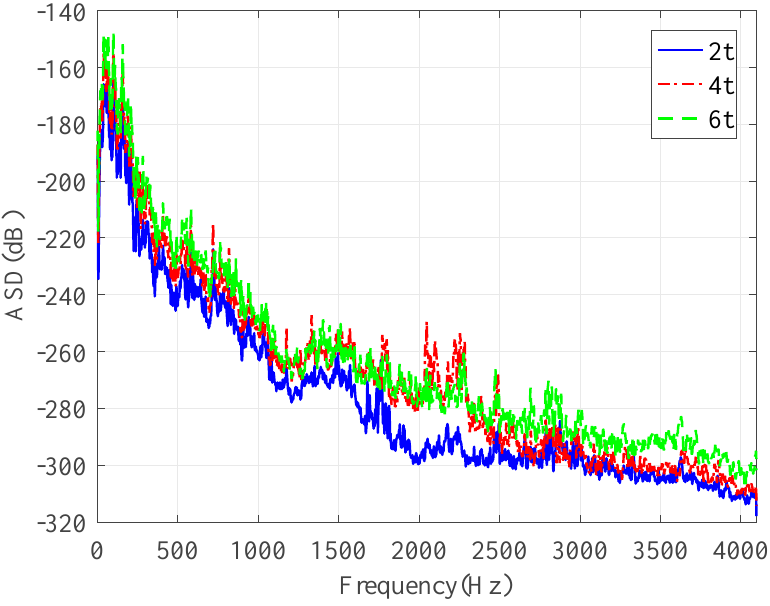
ff erent winding